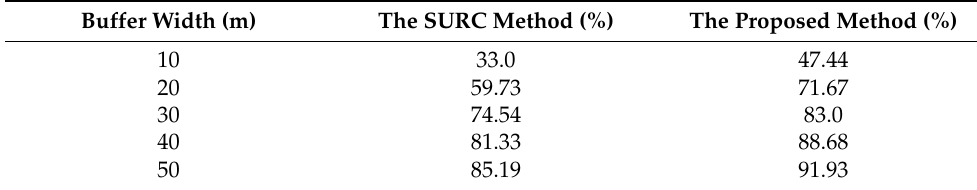
Table 5. Quantitative evaluation of geometric